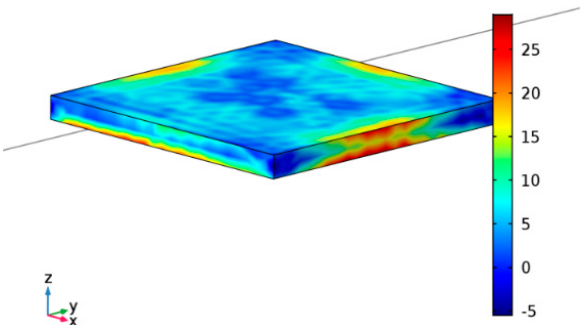
Figure 5. Stress distribution after 120 s at 50 W with the red color indicating tensile stress and the blue color compressive stress.